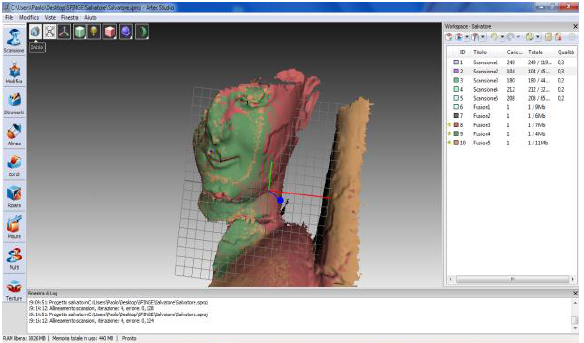
Figure 11. Overlapping scans in Artec Studio